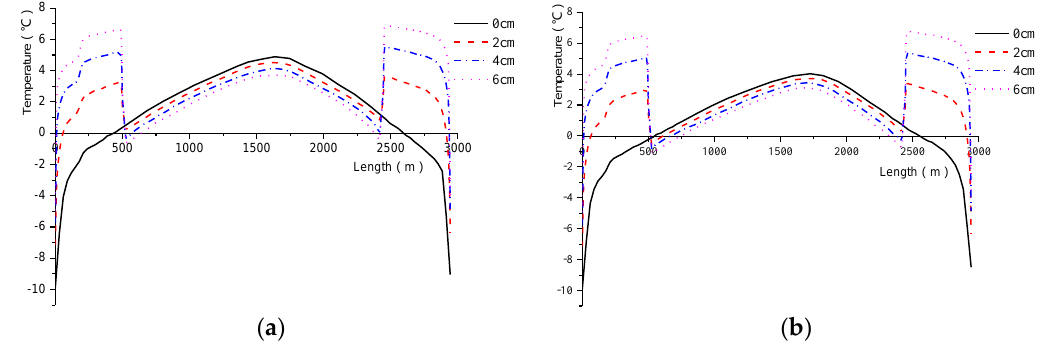
Figure 15. Average temperature in December of the surface of the tunnel secondary lining in the longitudinal direction (with different thicknesses of the heat-insulating layer): ( a ) under 5 m/s mechanical ventilation condition and ( b ) under 6 m/s mechanical ventilation condition.